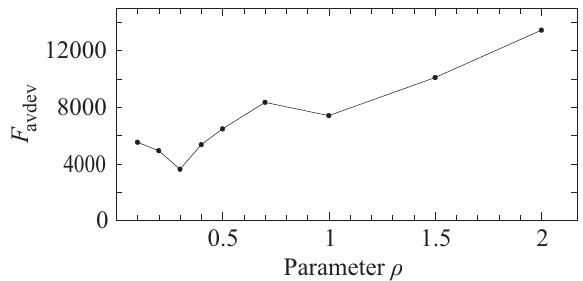
Figure 4. Average deviation F avdev versus parameter ρ .